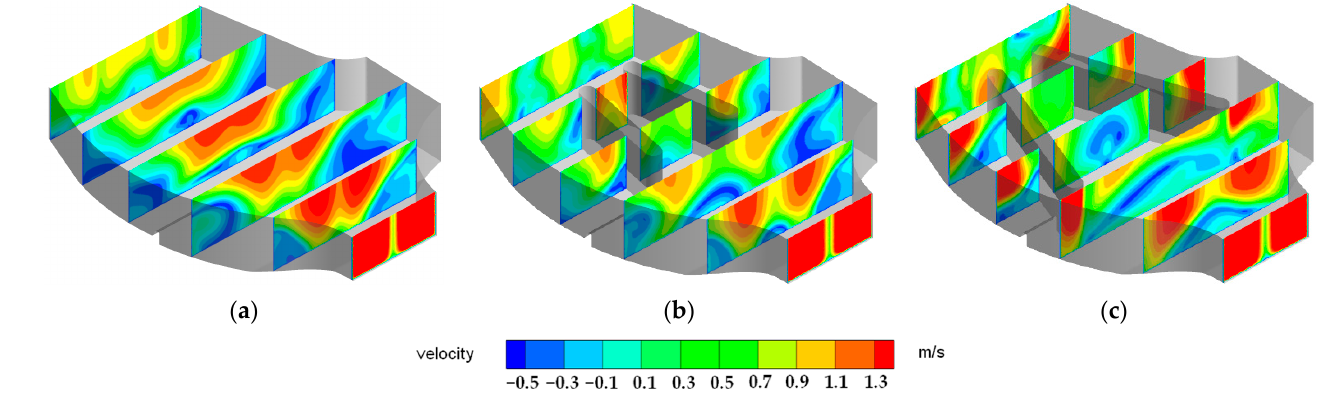
Figure 19. Flow rate distribution diagram of the forebay. ( a ) Scheme 0, ( b ) Scheme 1, and ( c ) Scheme 27.